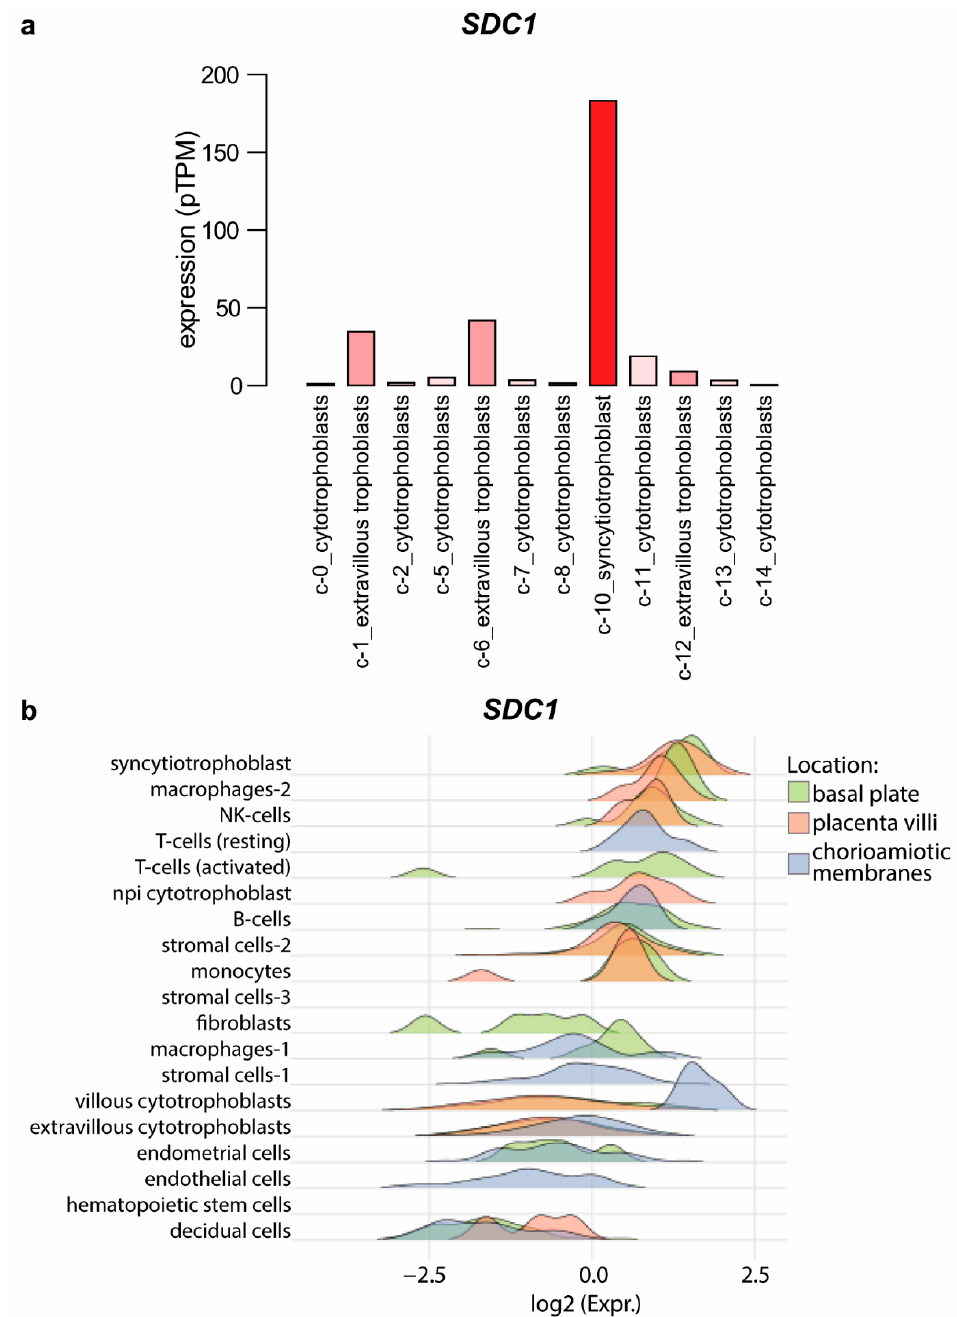
Figure 3. SDC1 expression in the placenta. ( a ) Single-cell RNA-seq data, derived from first-trimester placentas, were downloaded from the Human Protein Atlas [56]. The original study was performed by Vento-Tormo et al. [55]. SDC1 mRNA expression (pTPM) in trophoblast cell clusters (colored with shades of red) was visualized on a bar chart. ( b ) Single-cell RNA-seq data, derived from term placentas, were downloaded from http://genome.grid.wayne.edu/sclabor/ (accessed on 5 April 2022). The study was performed by Pique-Regi et al. [57]. SDC1 mRNA expression (normalized log 2 count data) in cell clusters in three placental compartments (basal plate, placenta villi, and chorioamniotic membranes) was visualized on a histogram chart. Non-proliferative interstitial—npi; protein-transcripts per million—pTPM.